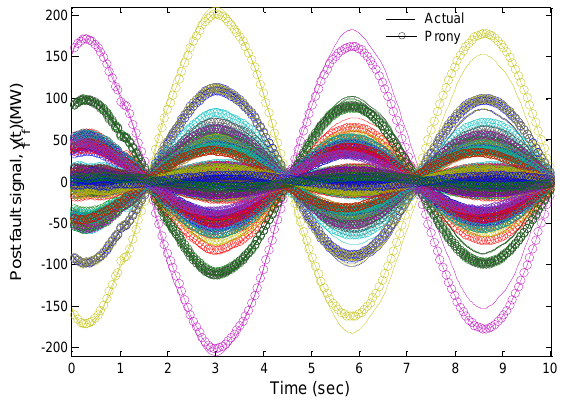
Fig. 9. Prony analysis using simulations of French power system.